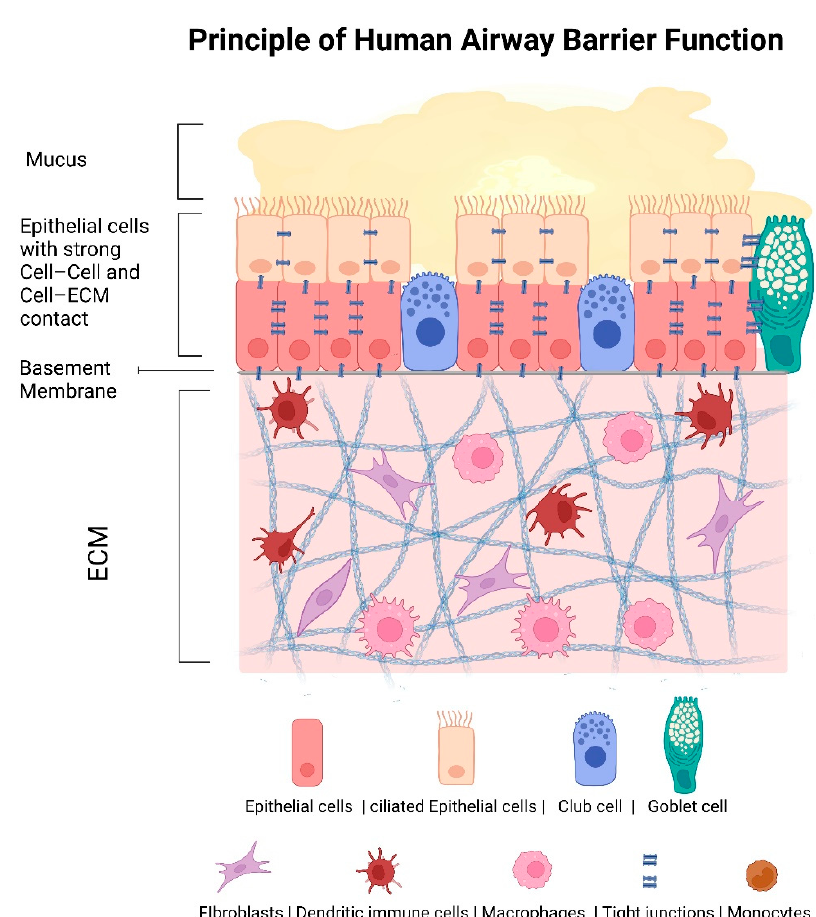
Figure 1. Cellular composition of the epithelial and subepithelial layers of the lower airway tract. The human lower airway tissue possesses a mucus barrier and an epithelial barrier through strong cell–cell and cell–ECM contacts. The epithelial layer contains ciliated cells that remove particles and pathogens through their cilia movement, nonciliated epithelial cells, and goblet and club cells. The subepithelial layer harbors, besides fibroblasts, also different immune cells like dendritic cells, monocytes, and macrophages. ECM—extracellular matrix. This figure was created with BioRender.com (accessed on 7 December 2021).